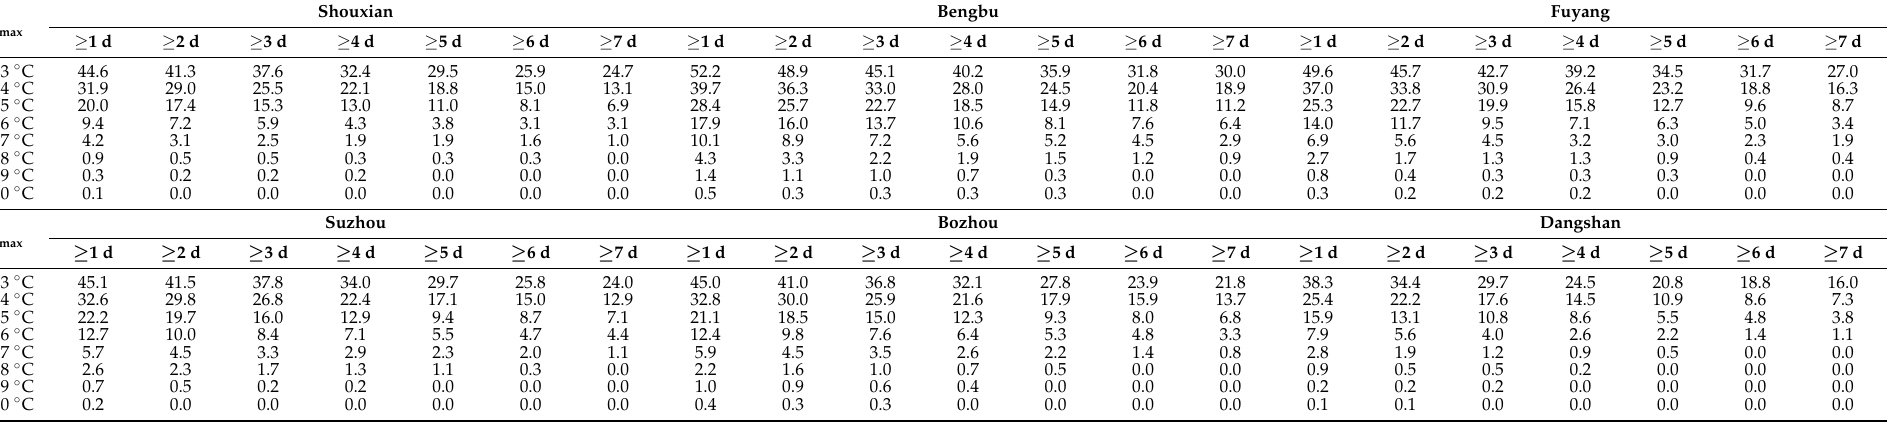
Table 3. The occurrence probability (%) of duration days (DDs) from 1 day to over 7 consecutive days and heat stress warnings during the flowering stage in six selected sites, i.e., Shouxian, Bengbu, Fuyang, Suzhou, Bozhou, and Dangshan, on Huaibei Plain, China.